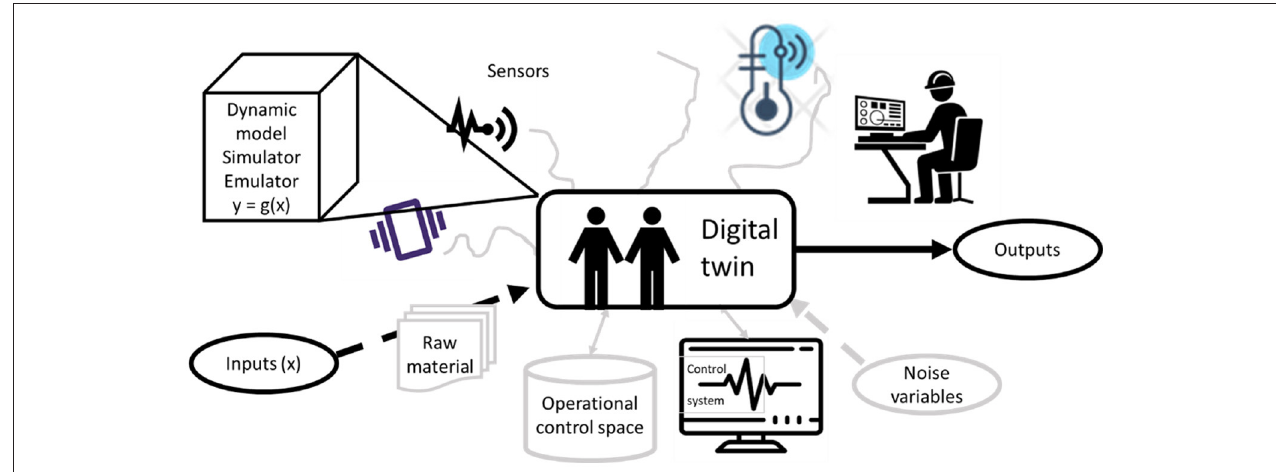
FIGURE 1 | Representation of the behavior of a digital twin and the use of emulators of the physical system. The picture was reproduced from Kenett and Bortman (2021)